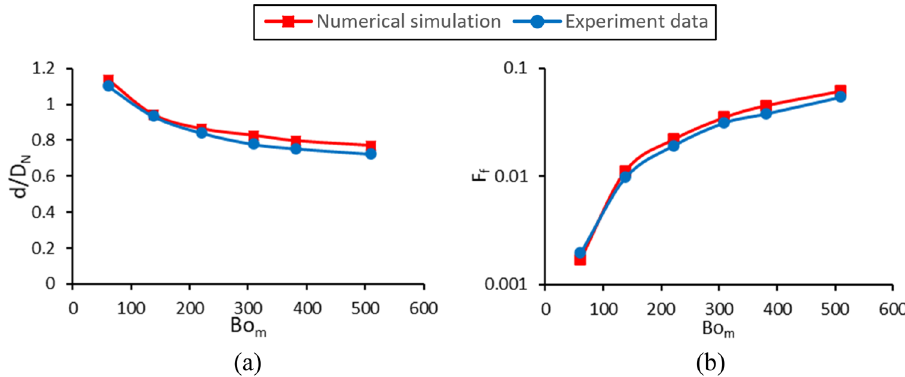
Figure 8. Variations of ( a ) the dimensionless droplet diameter and ( b ) the dimensionless formation frequency in terms of the magnetic Bond